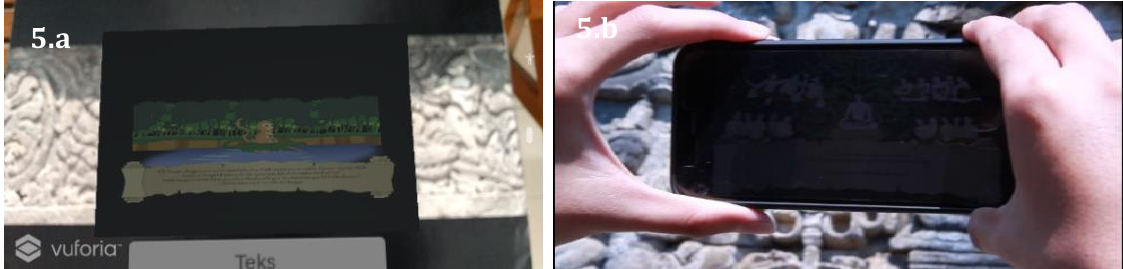
Fig. 4.a. Test on Printed Relief Carving Image , 4.b. Test on Actual Relief Carving